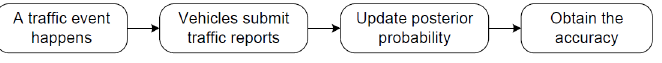
Figure 12. How to obtain the